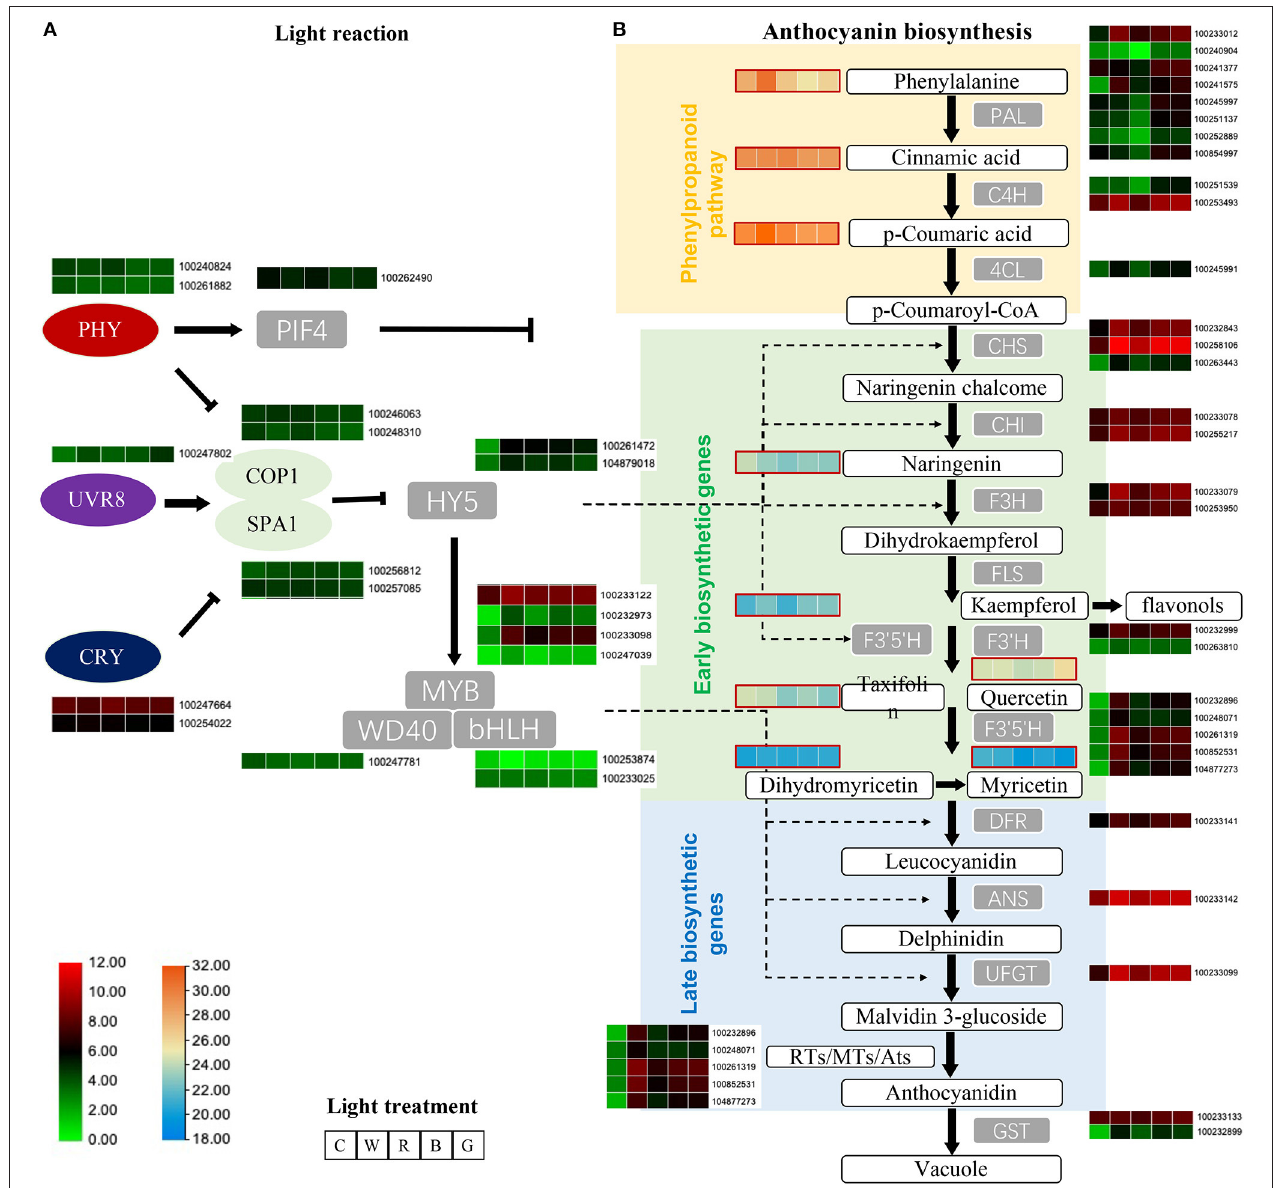
FIGURE 5 | Employ transcriptome and metabolome to explain the differences in light reaction (A) and anthocyanin biosynthesis (B) pathway genes and metabolites after different light quality treatments. The heatmap displays the expression levels of the genes (average of TPM value) and metabolite [average of log 10 (area value)], from left to right are C, W, R, B, and G. The panel shows in the lower left corner, respectively, indicate the amount of transcriptome (green to red) and metabolome (blue to orange). C: control (no light treatment), B: blue light treatment, R: red light treatment, W: white light treatment, G: green light treatment.